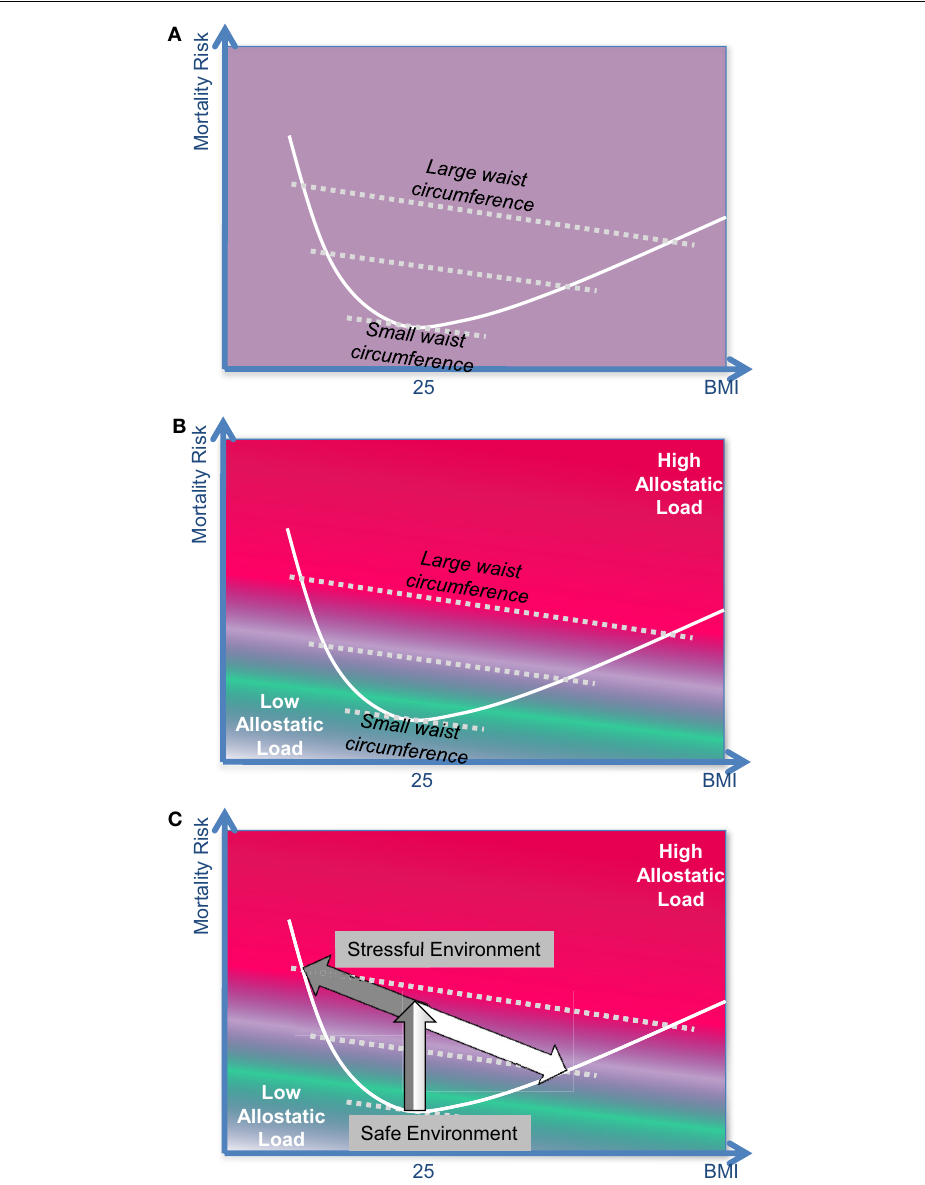
FIGURE 5 | The BMI-mortality association is confounded by “stress.” (A) The body mass index (BMI) is not sufficient to predict the mortality risk: modern mortality studies such as the EPIC-STUDY or the DANISH DIET, CANCER, AND HEALTH STUDY take into account both the BMI and the waist circumference to predict the mortality risk in humans. (B) Waist circumference and allostatic load: the size of the waist circumference can be considered as a clinical marker for the allostatic load a person has carried over the past years. In the upper part of the diagram (red part) the position of those subjects can be found who have carried a substantial stress burden in the past; at the bottom (green part) the position of relaxed, unburdened subjects can be found. (C) The effect of stress on the mortality risk in distinct phenotypes: type-A-individuals represent the left arm of the j-shaped curve, while type-B-individuals represent the right